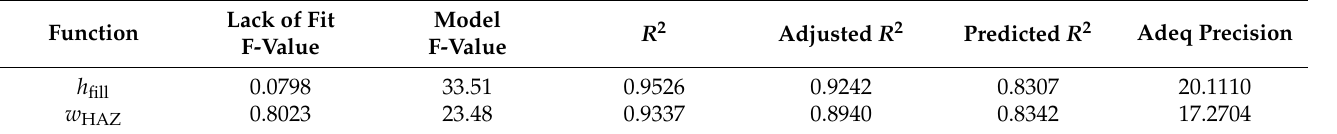
Table 7. Goodness of fit.